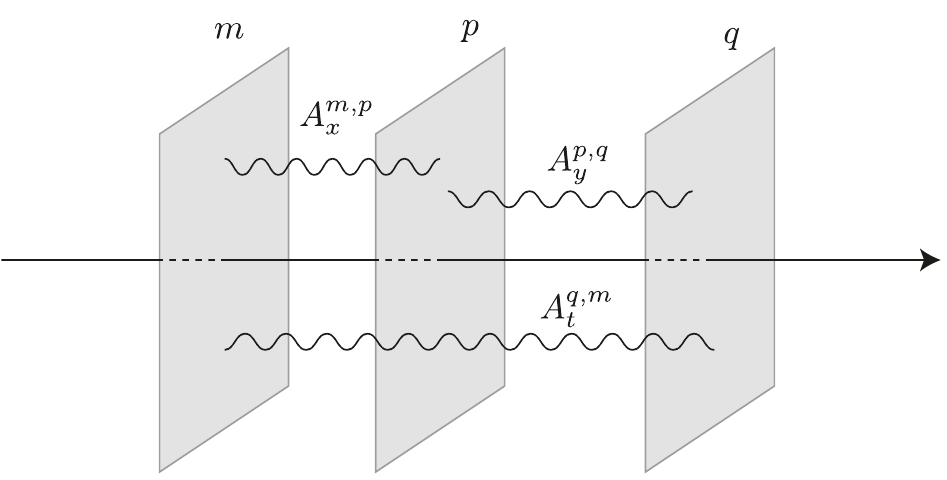
Figure 1 . In Step 1 of the T-duality, we go to the covering space, where each copy of the theory is labeled by an integer m , so that the original adjoint gauge (cid:12)eld A i = x;y;t are now upgraded to A m;n connecting m -th and n -th copies. We change the Lagrangian accordingly | for example, i = x;y;t the term Tr ( A x A y A t ) in the Lagrangian is replaced by Tr interaction between p; q and m -th